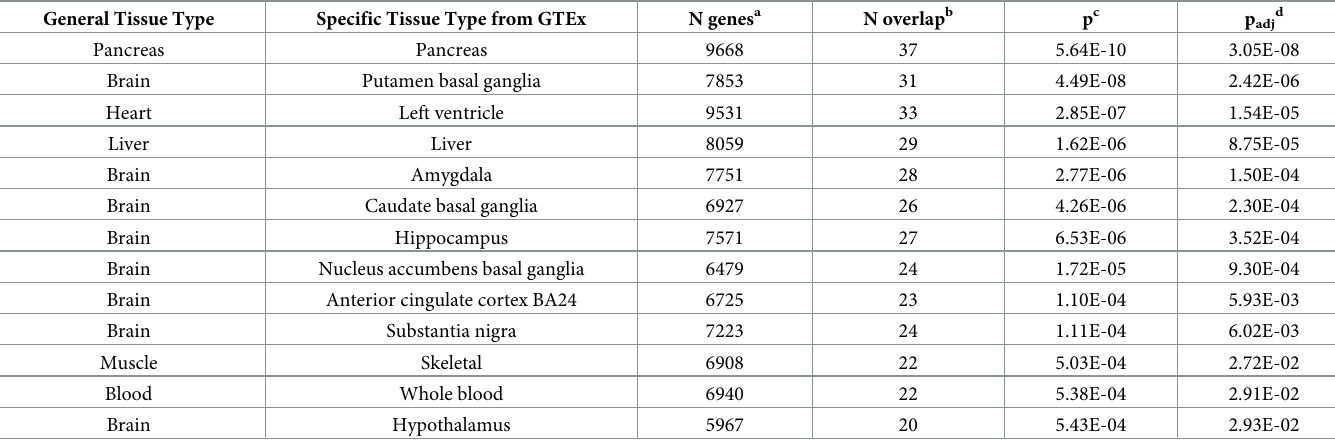
Table 4. Differentially expressed genes from FUMA using GTEx version 8 tissue expression. General Tissue Type